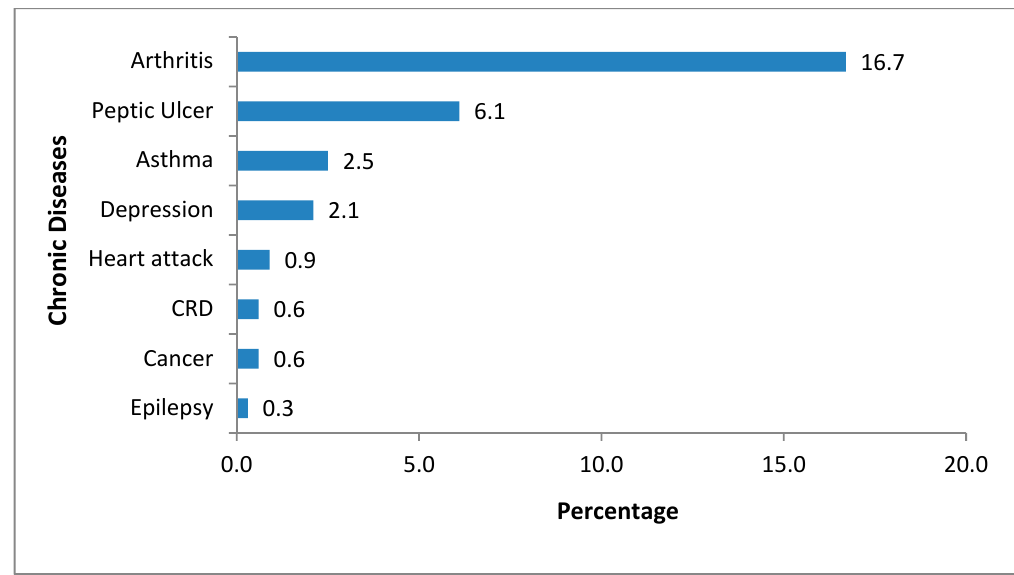
Figure 2. Prevalent non-communicable diseases among study participants ( n = 1100) with self-reported hypertension and/or diabetes.